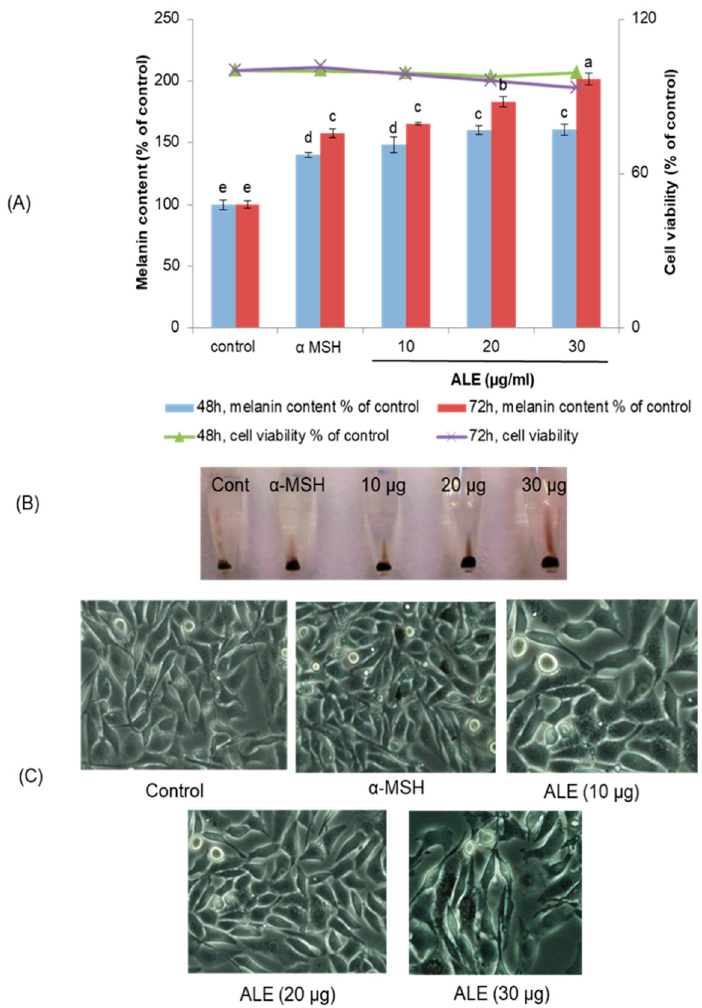
Figure 2. Melanin content and cell viability of argan leaves extract (ALE)-treated or α MSH-treated B16 cells. Cells were treated without (control) or with α -MSH (0.2 µ M) or ALE (10, 20 and 30 µ g/mL) for 48 h and 72 h. ( A ) Melanin content of the cells treated with ALE. Cells treated with 0.2 µ M α -MSH served as a positive control. The synthesized melanin and total number of cells were measured as described in Materials and Methods. The bar graph indicates the melanin content (left-hand y-axis) while the line graph indicates cell viability (right-hand y-axis). The results are presented as the mean ± SD of three independent experiments; different letters on the histograms indicate significant difference between treatments ( p ≤ 0.05) (ANOVA Tukey’s test). ( B ) Photograph of extracted melanin pellet from B16 cells treated without (control) or with α -MSH (0.2 µM), or ALE (10, 20 and 30 µ g/mL). ( C ) Images of B16 cells treated without or with ALE or α -MSH (400× magnification).